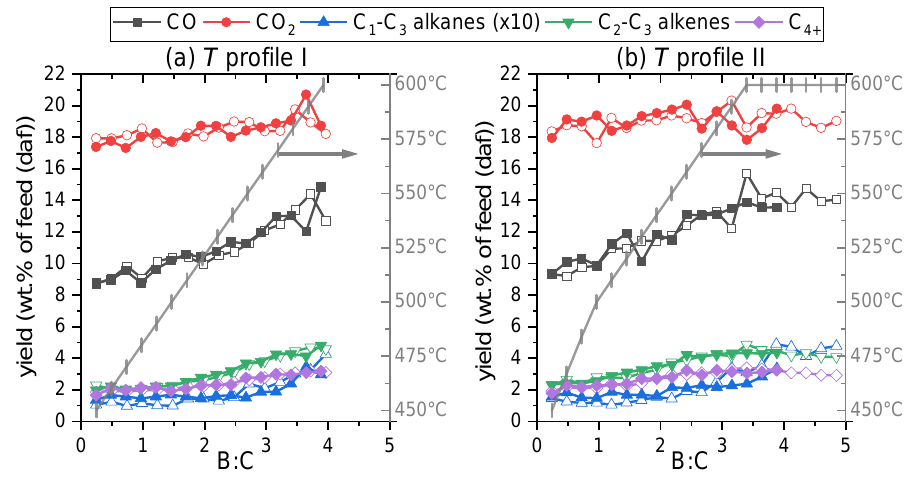
Figure 2. Change in momentary gas yields with increasing biomass injection when ( a ) increasing the catalyst temperature following temperature profile I, and ( b ) following temperature profile II. The yield of C 1 -C 3 alkanes was multiplied by a factor of 10. Catalyst: P/HZSM-5/γ-Al 2 O 3 . Open symbols show results from replicate runs.